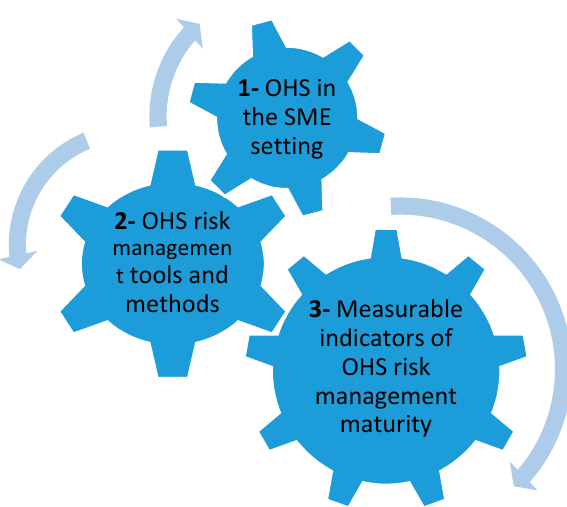
Figure 1. Principal elements of the research problem. OHS: occupational health and safety; SME: small-to-medium-sized enterprise.